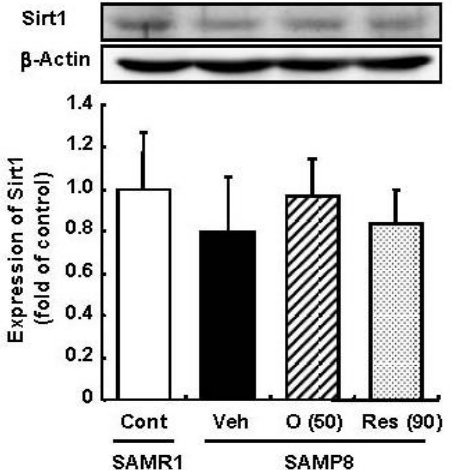
Figure 3. Effects of oligomers on Sirt1 expression in the brain of SAM. Forty-five-week-old SAMP8 were administered vehicle (Veh, water p.o., n = 5), oligomers (O (50), 50 mg/kg B.W./day, p.o., n = 5), or resveratrol (Res (90), 90 mmol/kg B.W./ day, p.o., n = 5). After 5 weeks of administration, brain lysates were immunoblotted with antibodies for Sirt1. Sirt 1 expression intensities were divided by  -actin expression. SAMR1 mice were used as a control (Cont, n =